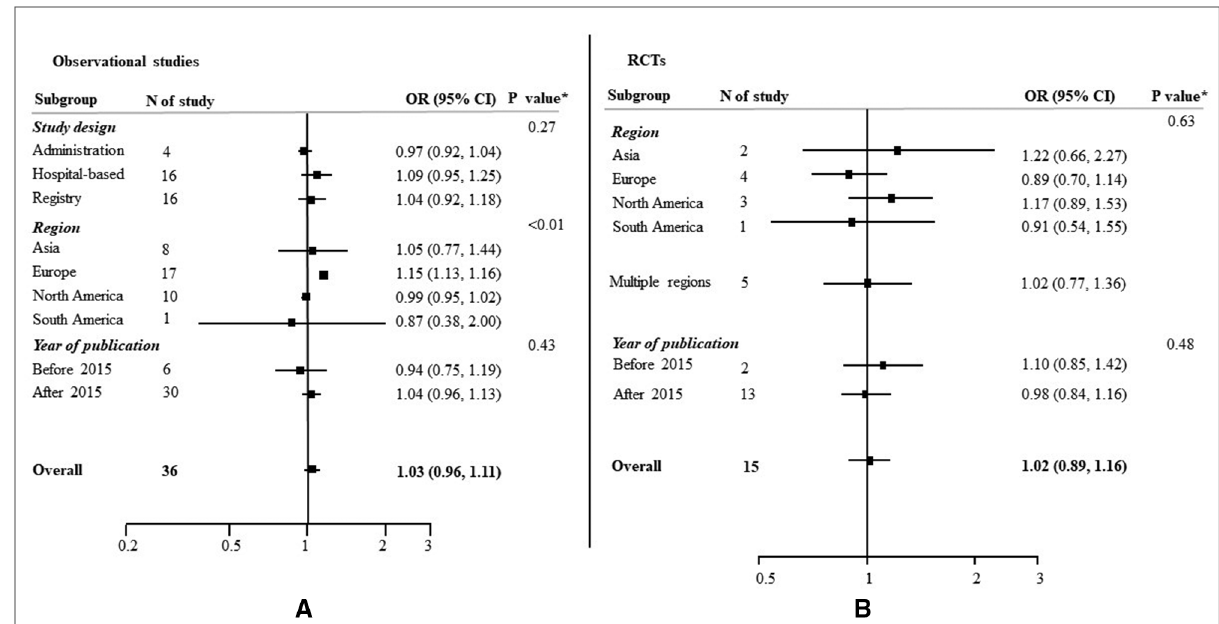
FIGURE 3 Odds ratios (OR) of EVT use for women compared to men, with 95% con fi dence intervals (CIs), by study type. CI, con fi dence interval; OR, odds ration; RCT, randomized controlled trial. * p value from Qb